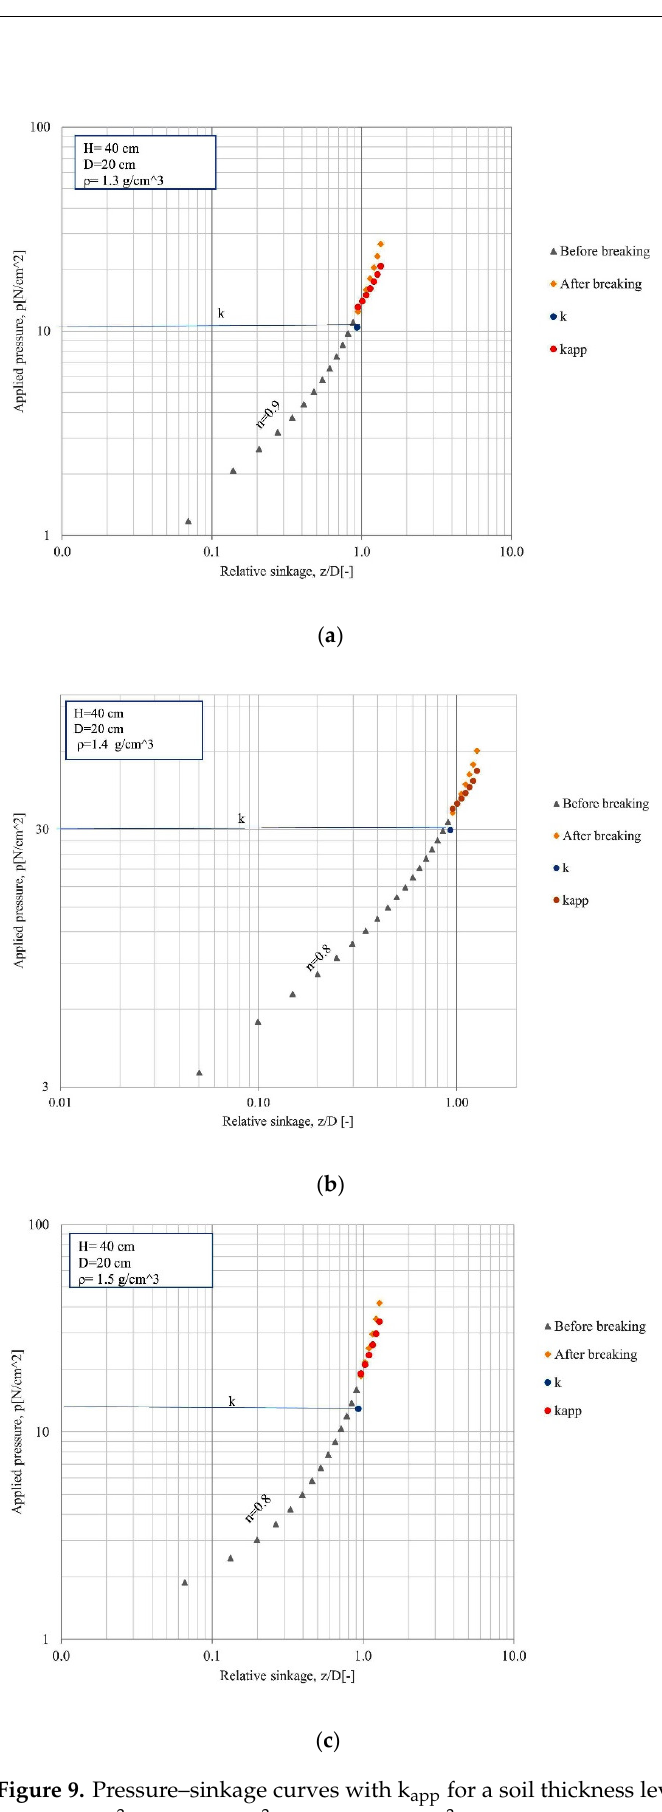
Figure 9. Pressure–sinkage curves with k app for a soil thickness level of 40 cm at bulk densities of ( a ) 1.3 g/cm 3 , ( b ) 1.4 g/cm 3 , and ( c ) 1.5 g/cm 3 .